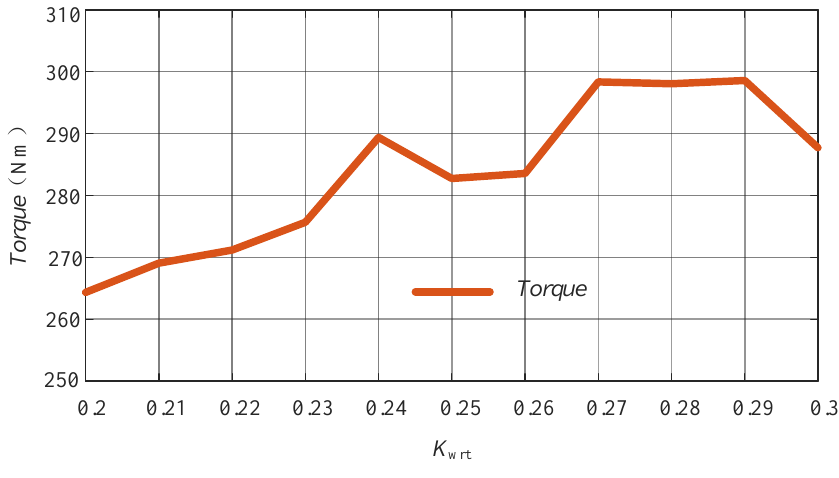
Figure 6. Relationship between torque and K wrt of FSPM generator.